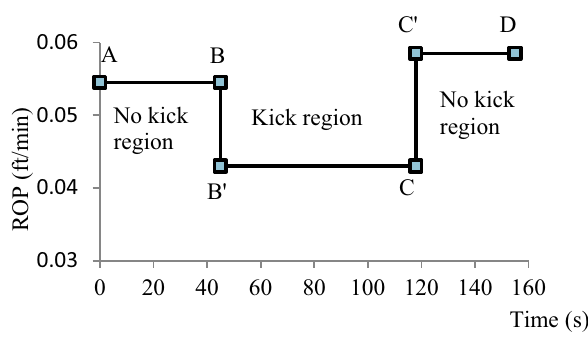
Fig. 10 Effects of gas kick on ROP for experimental Run_1